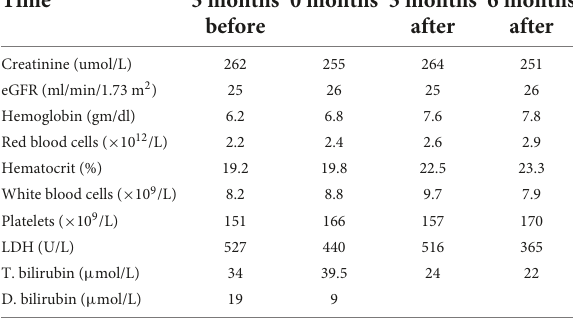
TABLE 1 Laboratory results 3 months before, at starting voxelotor, 3 months, and 6 months after.